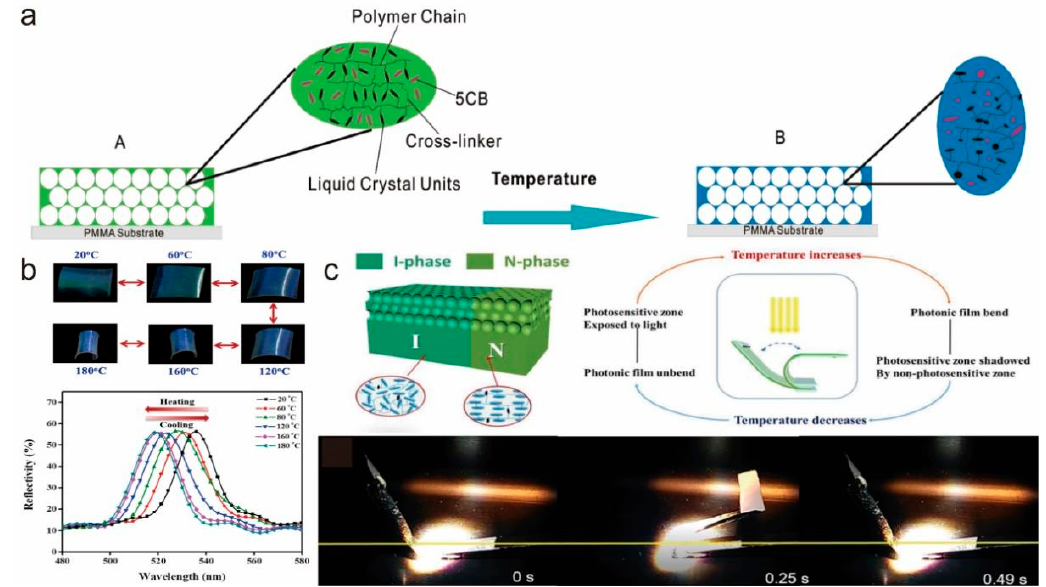
Figure 8. ( a ) Schematic diagram of the structure changing in an LCE-based inverse opal membrane with increasing temperature (Reprinted with permission from Ref. [82]. Copyright 2011, American